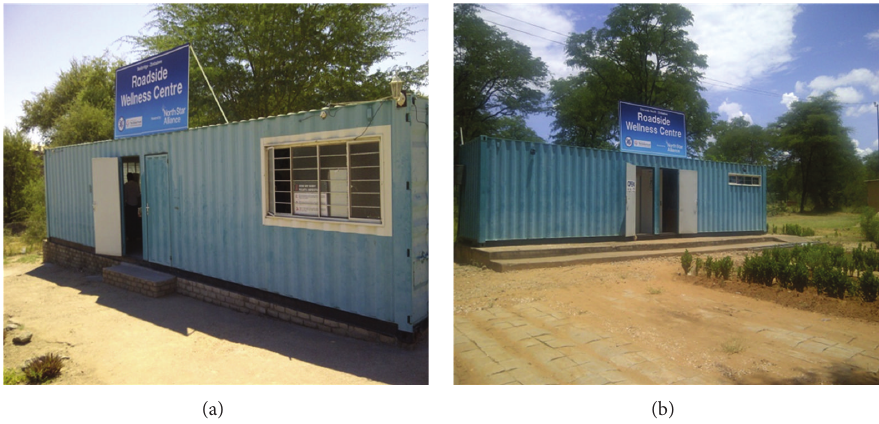
Figure 1: Roadside Wellness Centres in Chirundu South and Beitbridge,